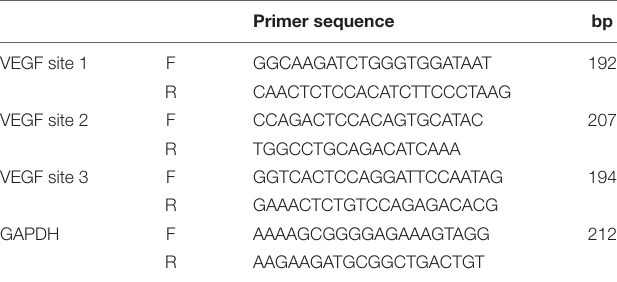
TABLE 3 | Primers used for ChIP PCR and